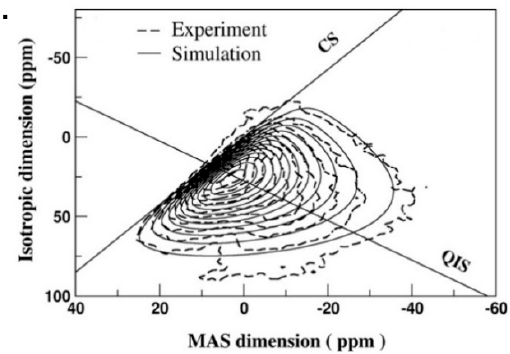
Figure 8. Fittings of 67 Zn 1D MAS NMR acquired for a metal-organic framework material ZIF-62 in its crystalline ( a , b ) and glass ( c , d ) forms, at two different fields 19.6 and 35.2 T as indicated in the figure. Blue dashed lines in ( a , b ) are quadrupolar fitted crystalline sites and red dashed lines are the sum of the fittings. Red dashed lines in ( c , d ) are disorder fittings resulted from Czjzek model. ( e ) shows a representative Czjzek fitting for 2D MQMAS spectrum acquired for 23 Na of a disordered sodium silicate glass material. ( a – d ) are adapted from Ref. [1]. Reprinted with permission from AAAS. ( e ) is reprinted from Ref. [66], Copyright (2011), with permission from Elsevier.